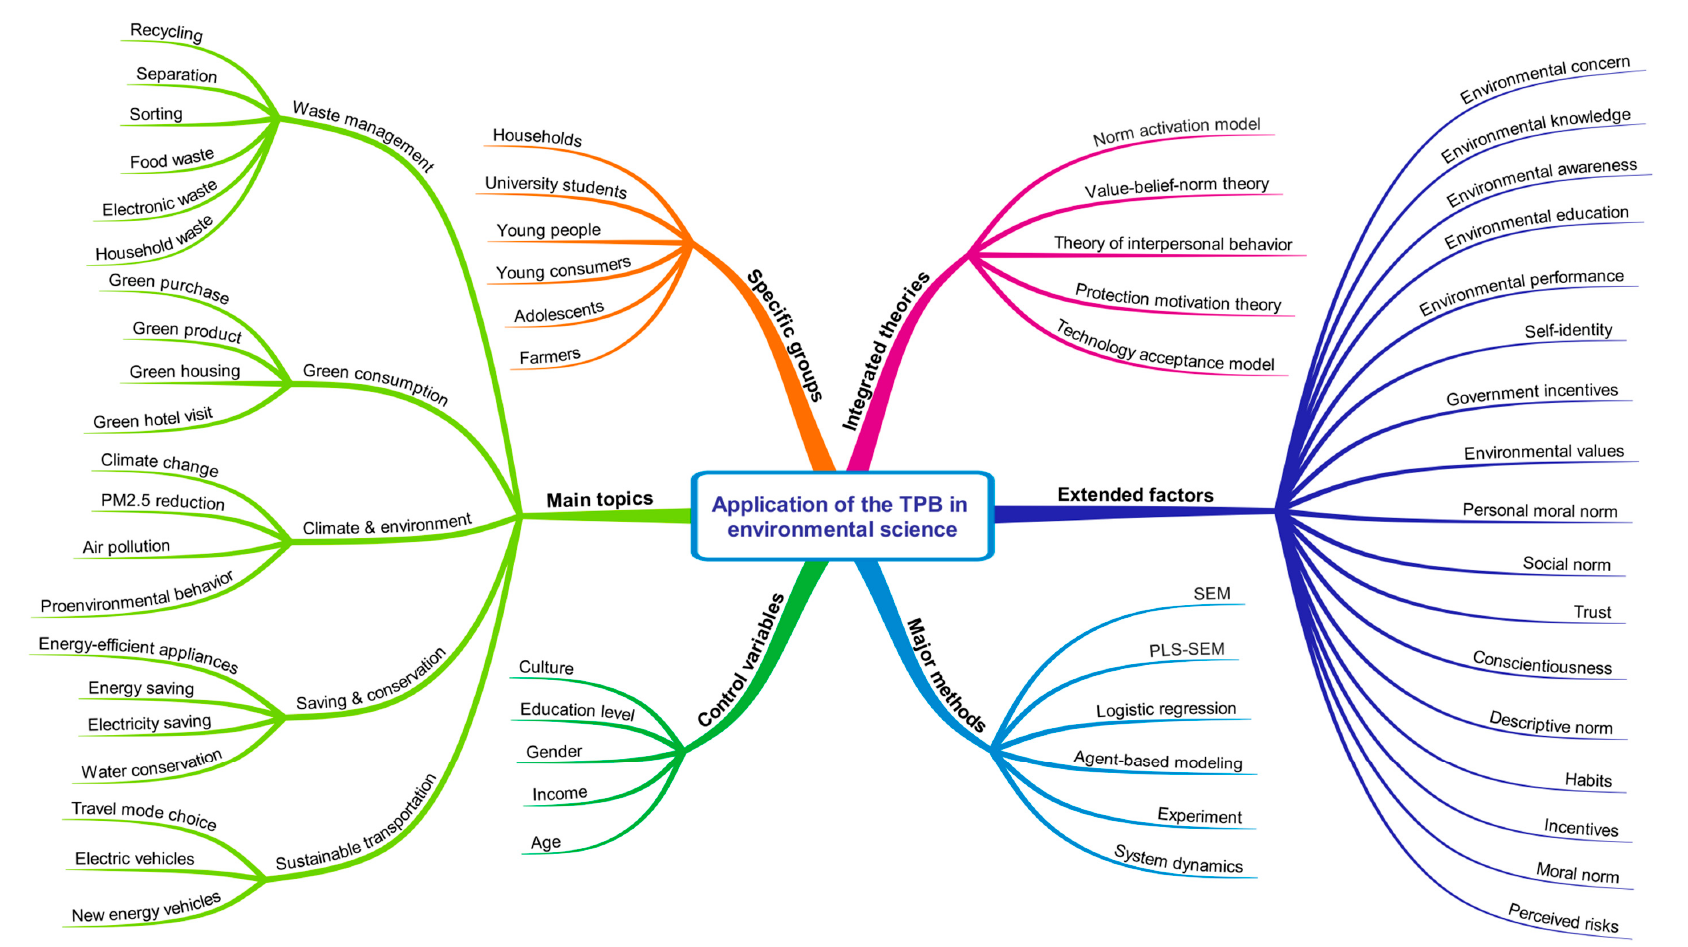
Figure 9. Application framework of the TPB in environmental science: 1995–2019.